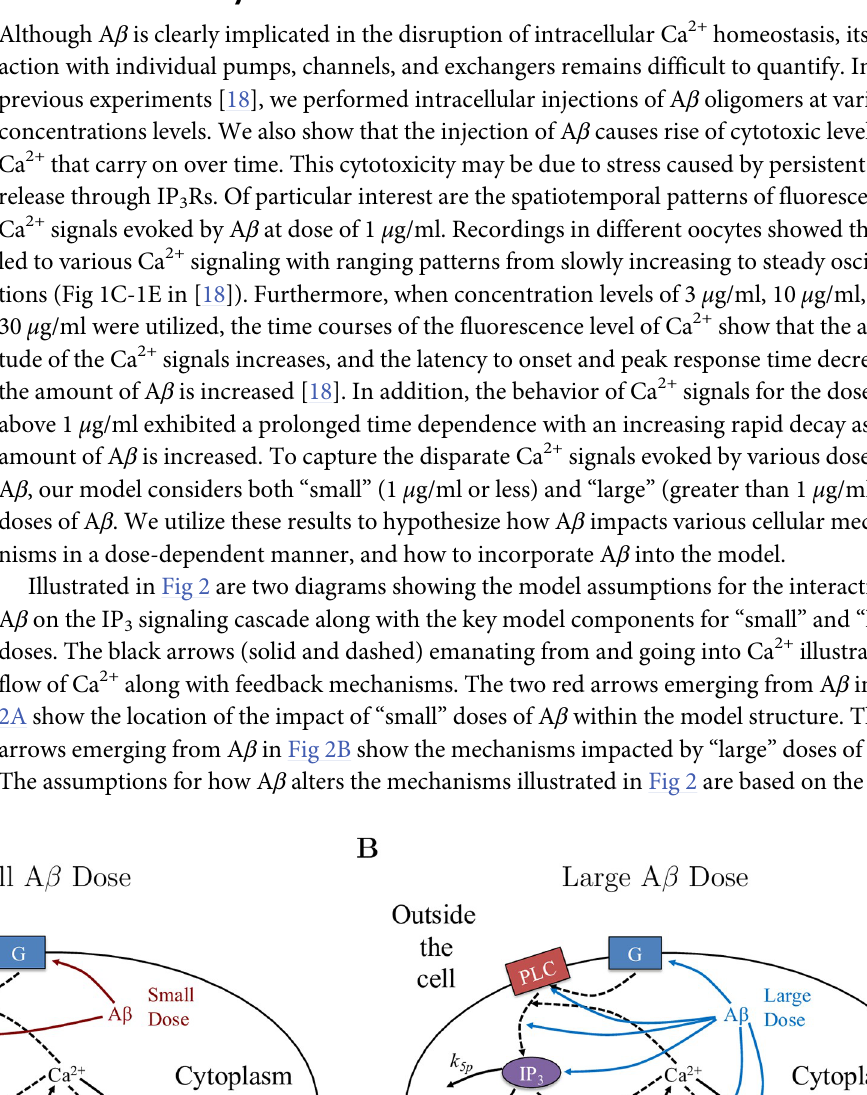
PLOS ONE | https://doi.org/10.1371/journal.pone.0246116 January 28,